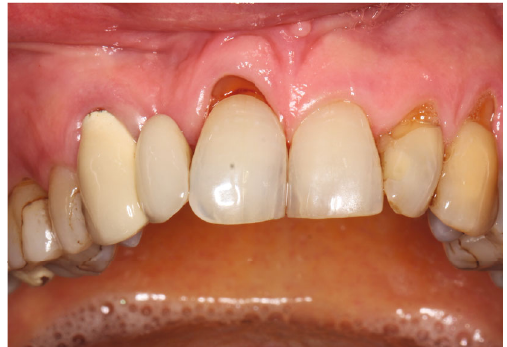
Figure 1: Initial situation with mesial trailer bridge on tooth 13 with missing tooth 12.